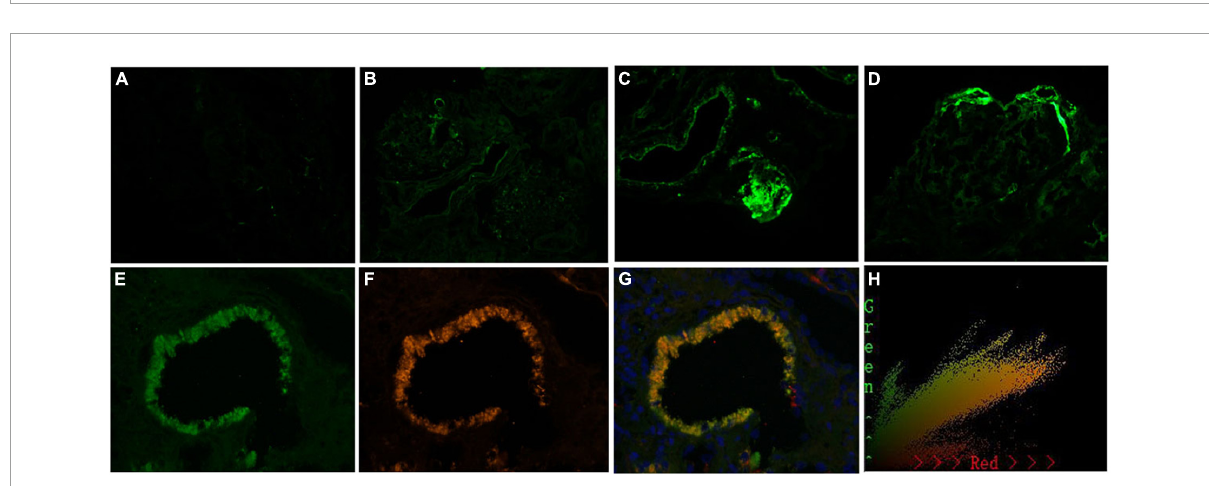
FIGURE6 Representative images of immunofluorescence staining for C3c in arteries grade 0–3 + , and the colocalization of C3c and CD31 in patients with immunoglobulin A nephropathy (IgAN). Granular positive staining for C3c by immunofluorescence along intrarenal arterioles in patients with IgAN. (A) Negative. (B) 1 + intensity. (C) 2 + intensity. (D) 3 + intensity. (Original magnification × 200). (E) Granular positive staining for C3c, and (F) Granular positive staining for CD31 (biomarker of endothelial cells) by immunofluorescence along intrarenal arterioles. (G) C3c and CD31 colocalized along the intrarenal arterioles. (H) The corresponding 2-dimensional fluorograms have been included to confirm the degree of colocalization (Pearson correlation = 0.928389, overlap coefficient = 0.928594). (Original magnification × 400).